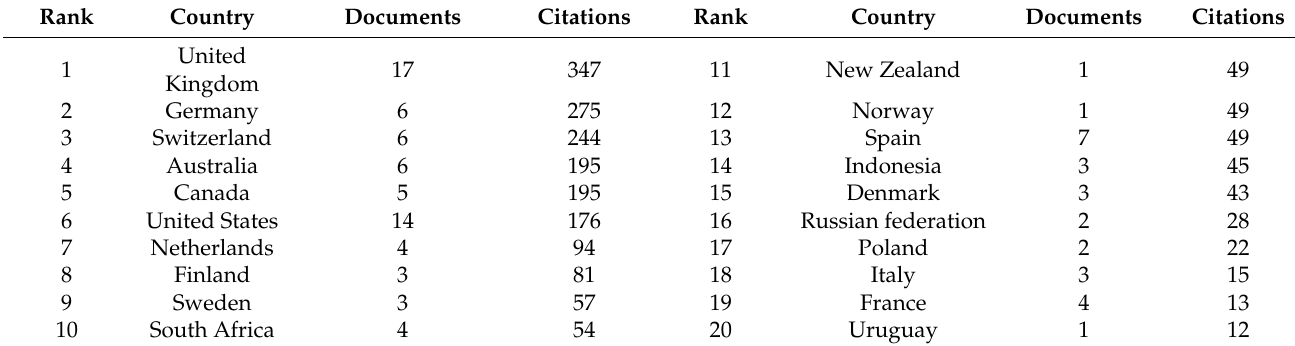
Table 5. Country-wise searched result of